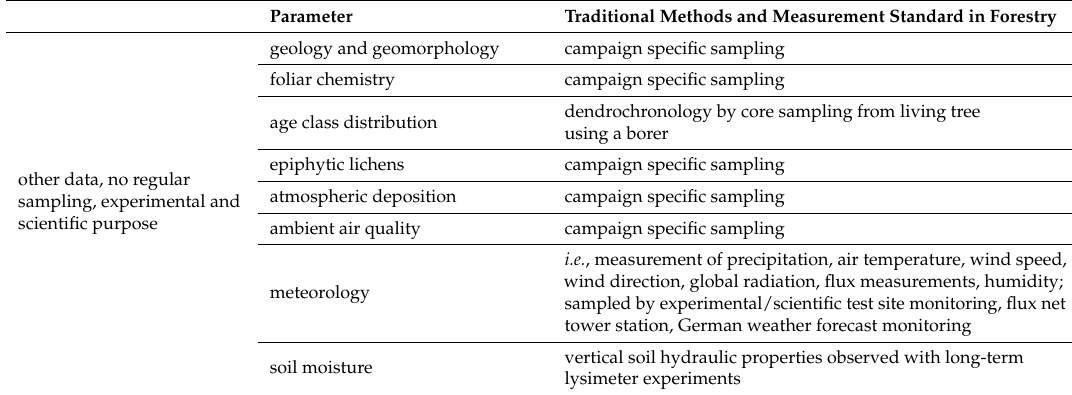
Table 2. Cont. Traditional Methods and Measurement Standard in